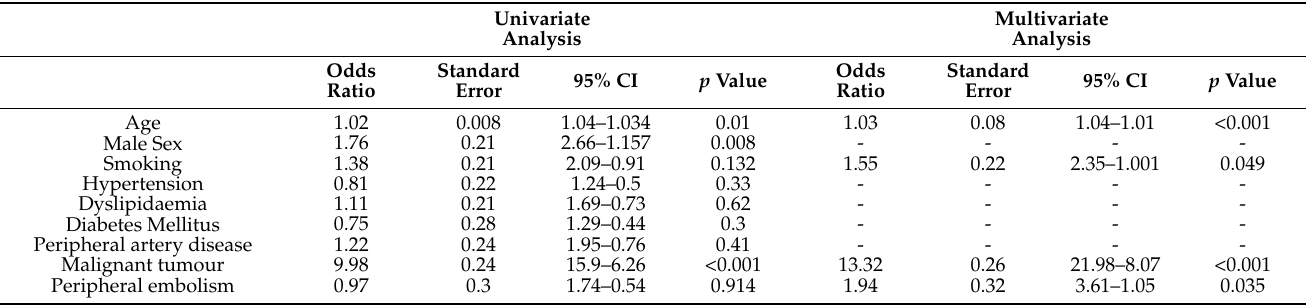
Table 6. Univariate and multivariable logistic regression model showing the clinical predictors of death during follow up in patients with Cardiac